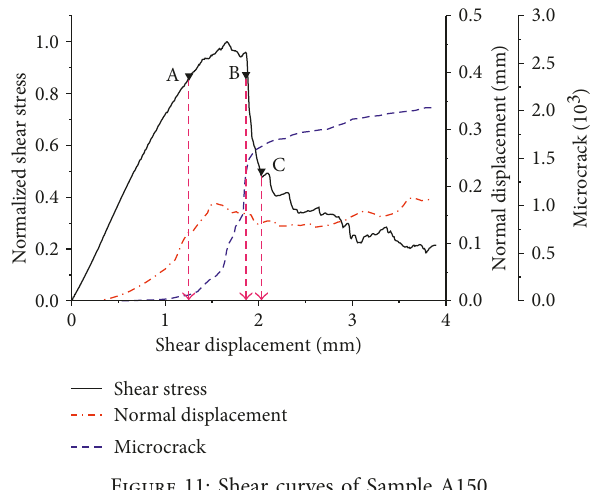
Figure 11: Shear curves of Sample